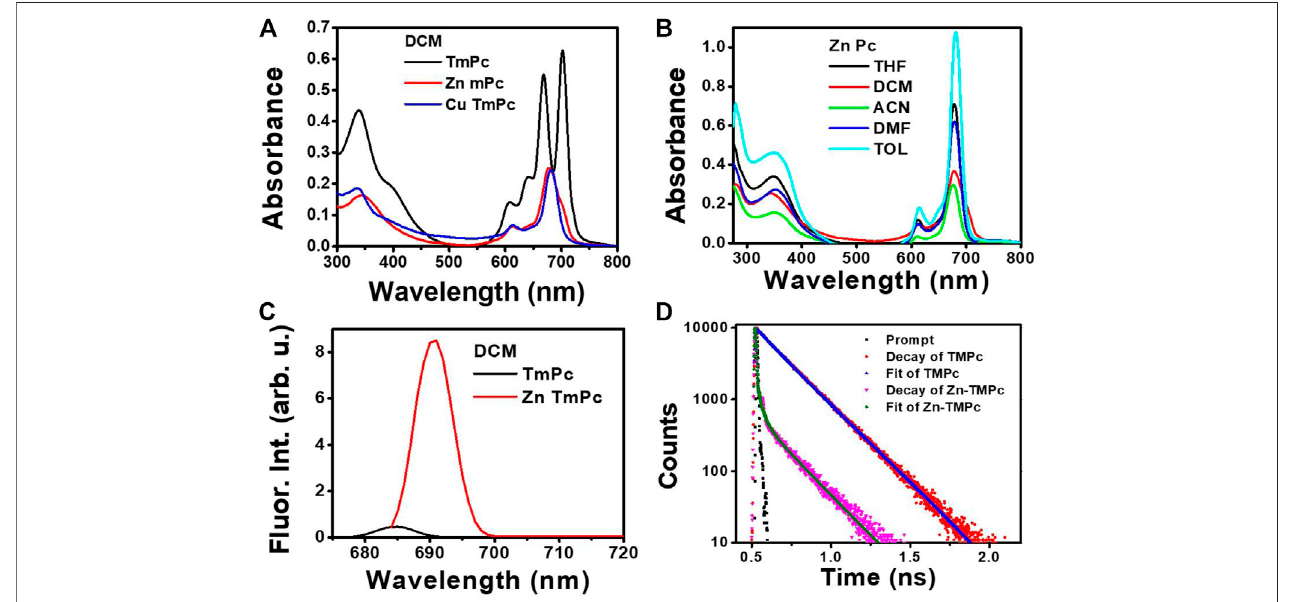
FIGURE 2 | (A) Absorption spectra of TmPC, CuTmPc, and ZnTmPc in the DCM solvent (B) Absorption spectra of ZnTmPc in different solvents (C) Emission spectra of TmPc and ZnTmPc in the DCM solvent (D) Fluorescence decay curves of TmPc and ZnTmPc in the DCM solvent. “ arb. u. ” stands for arbitrary units.